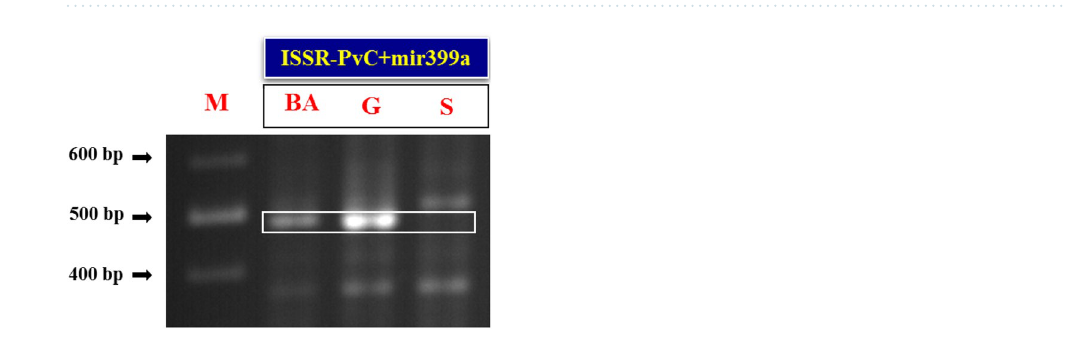
Figure 4. Frequency distribution of the first five abundant di-, tri- and penta-nucleotide repeat of SSR motifs. ( A ) Exclusive salt responsive genes in Ghazvini after 24 h compared to 6 h salt treatment. ( B ) Exclusive salt responsive genes in Ghazvini compared to Sarakhs after 6 h salt treatment. The red box represents the SSR motifs selected for ISSR primer design.